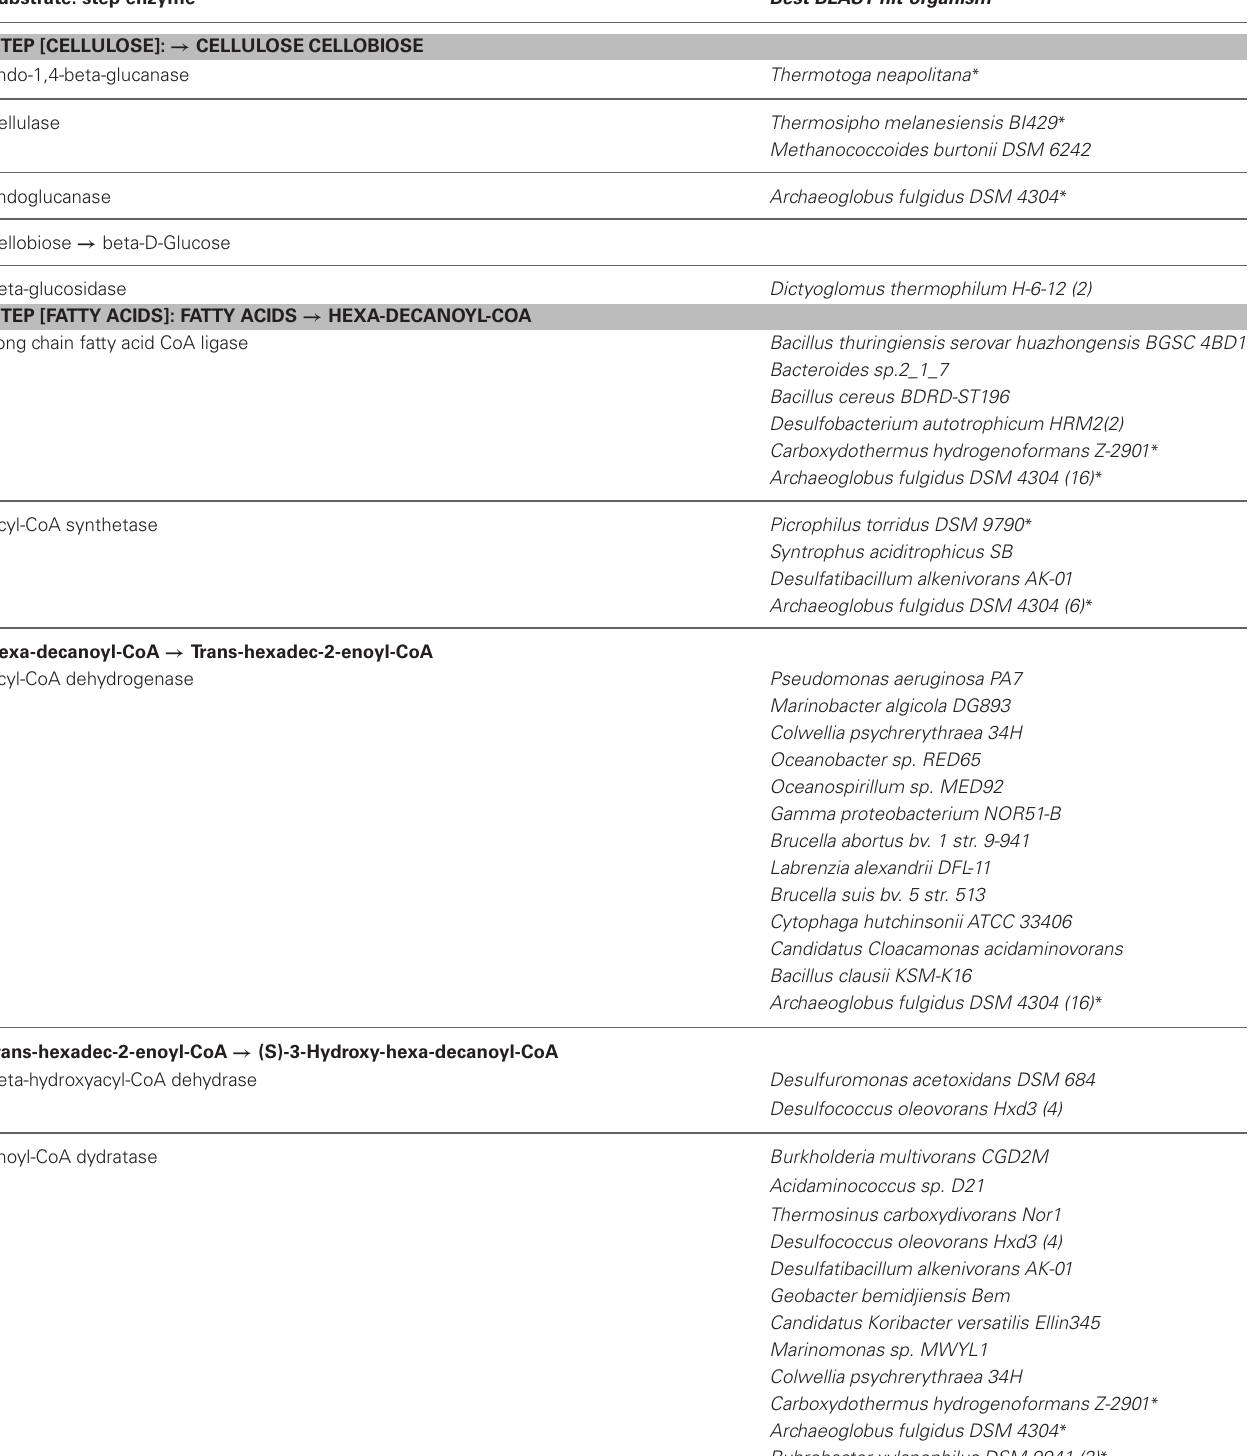
Table A2 | List of annotated protein features involved in degradation processes. Substrate: step